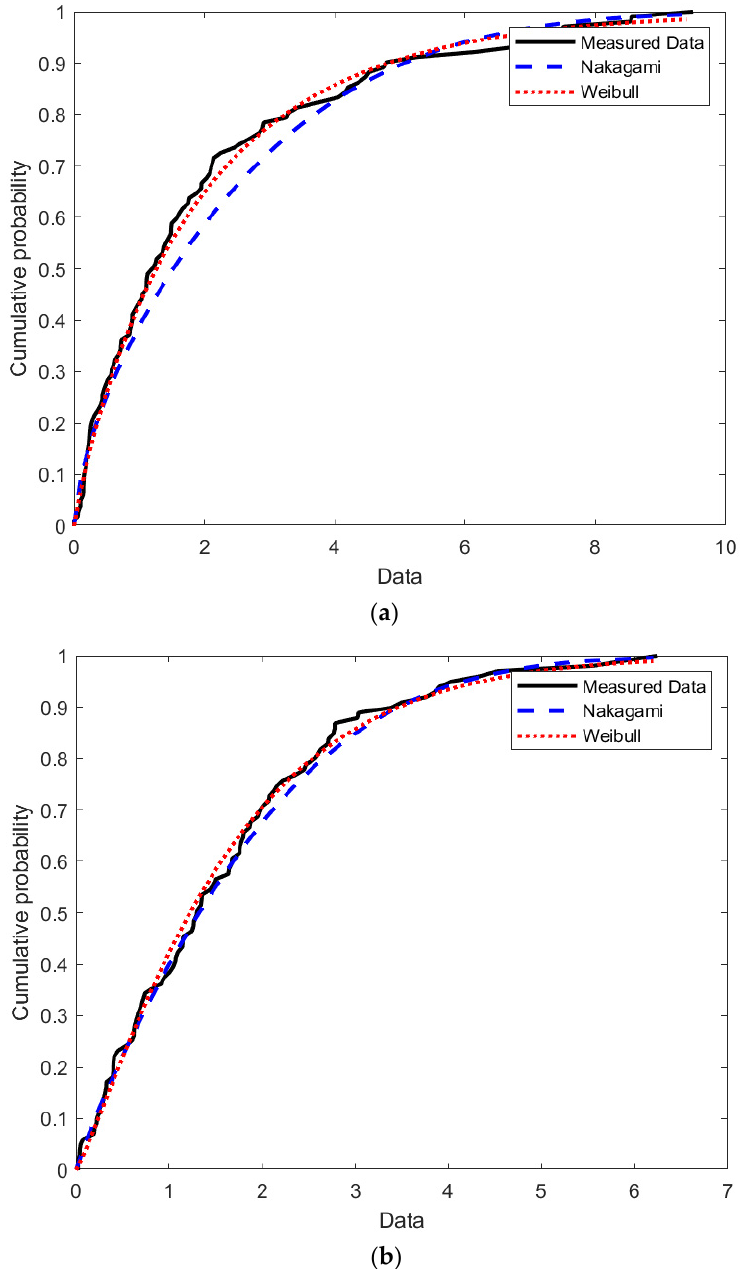
Figure 13. Cumulative distribution functions fitting fast variations within the small lab #2 at 3 GHz. ( a ) Furnished; and ( b ) empty.